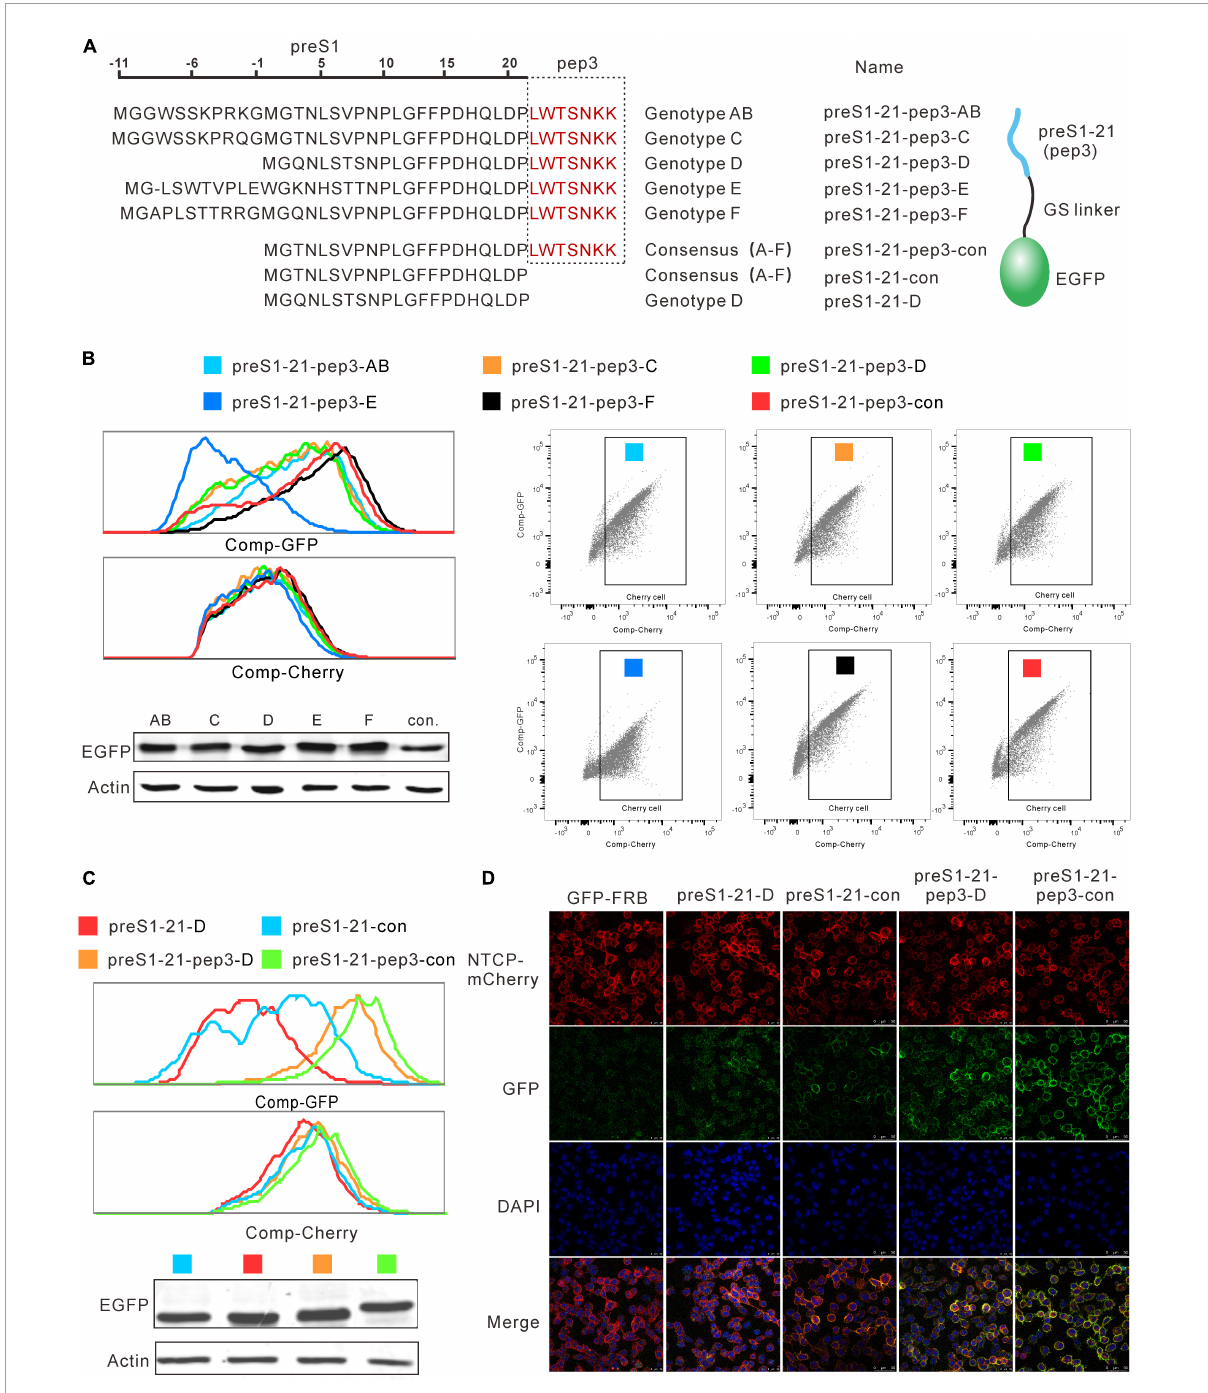
FIGURE4 Effects of combining pep3 with different genotypes of preS1-21. (A) Plasmids expressing pep3-GFP fused with preS1-21 from genotype A to F and the consensus sequence of A to F were constructed for the evaluation. (B) Evaluation of the binding capability for NTCP of pep3 combined with preS1-21 from different genotypes. preS1-21-pep3-F and preS1-21-pep3-con showed the highest binding capability whereas preS1-21-pep3-E the lowest. Western blot was used to check the expression levels of different proteins. (C) Evaluation of preS1-21-pep3-con’s ability to bind NTCP. PreS1-21-pep3-con showed a higher binding capacity than preS1-21-D, and preS1-21-pep3-con demonstrated a higher binding capacity than preS1-21-pep3-D. Notably, compared to preS1-21-D and preS1-21-con, both preS1-21-pep3-D and preS1-21-pep3-con showed a much higher binding capability. (D) Evaluation of the binding ability by confocal microscopy. preS1-21-pep3-con and preS1-21-pep3-D displayed an apparently higher binding to the cell membrane (green fluorescence) than preS1-21-con and preS1-21-D, while the negative control (GFP-FRB) had only scatter